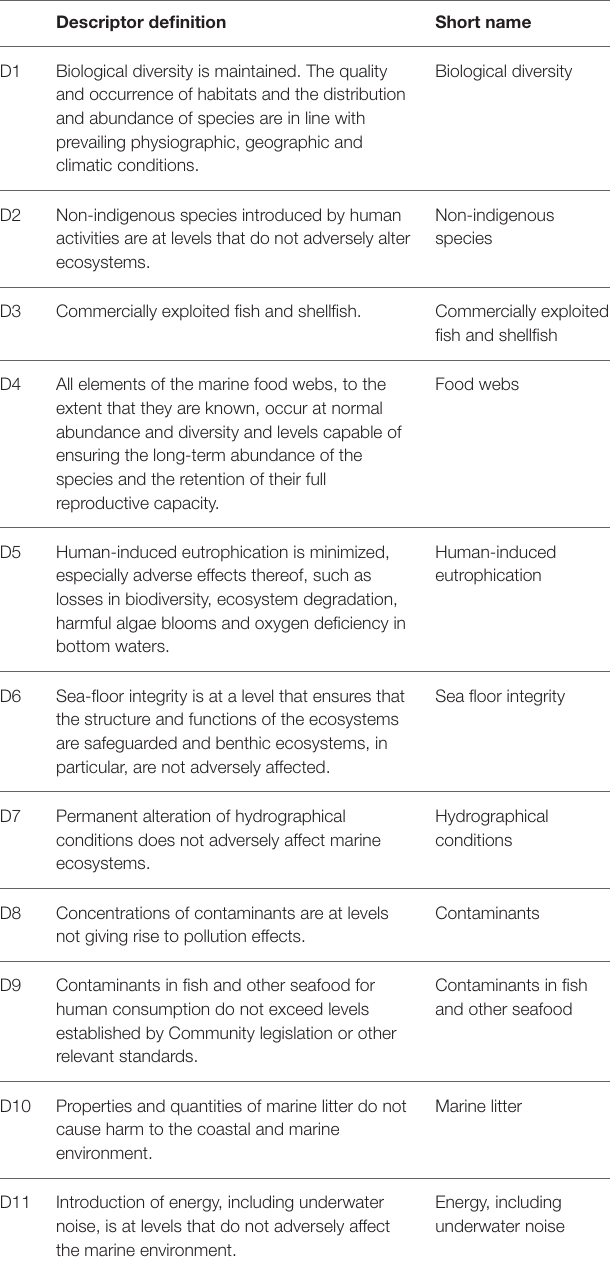
TABLE 1 | MSFD Descriptors (according to Annex 1,